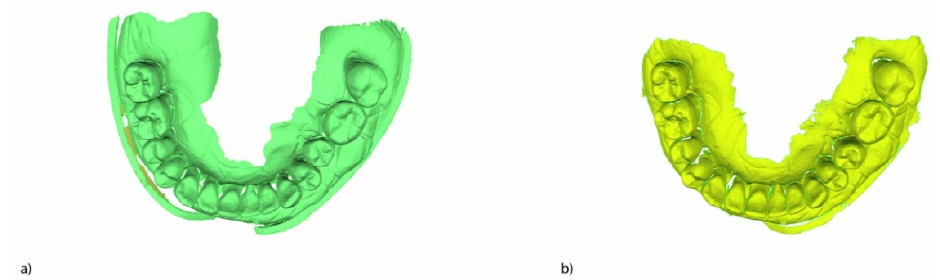
Figure 1. ( a ) Occlusal view of the standard tessellation language (STL) digital file of the experimental model with the embedded teeth before and ( b ) after the 0.2 mm interproximal enamel reduction procedure using air-rotor strips and the interproximal enamel reduction technique.